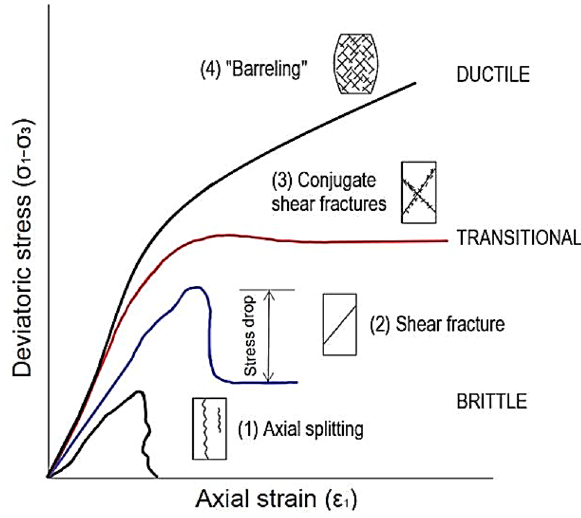
Figure 4. Typical stress–strain curves in brittle, brittle-ductile, and ductile states (modified after 31,47 ).